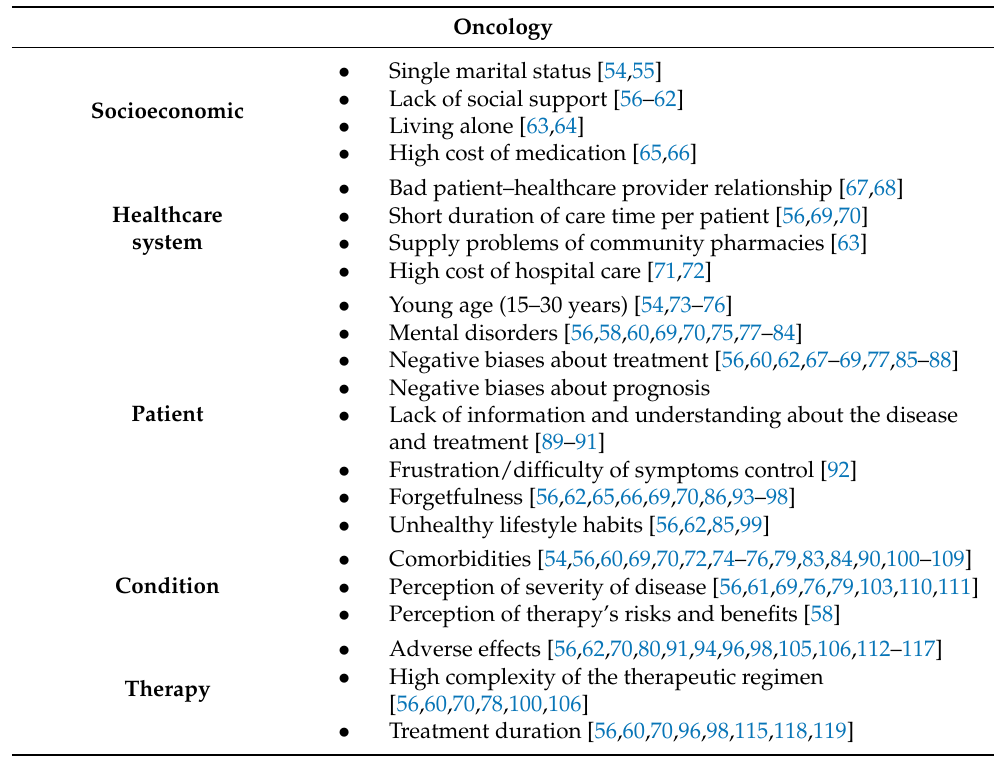
Table 2. Oncology risk factors of